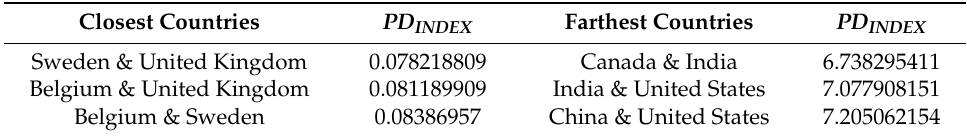
Table 4. Example of the closest and farthest countries in the sample in term of psychic distance. Source: Authors’